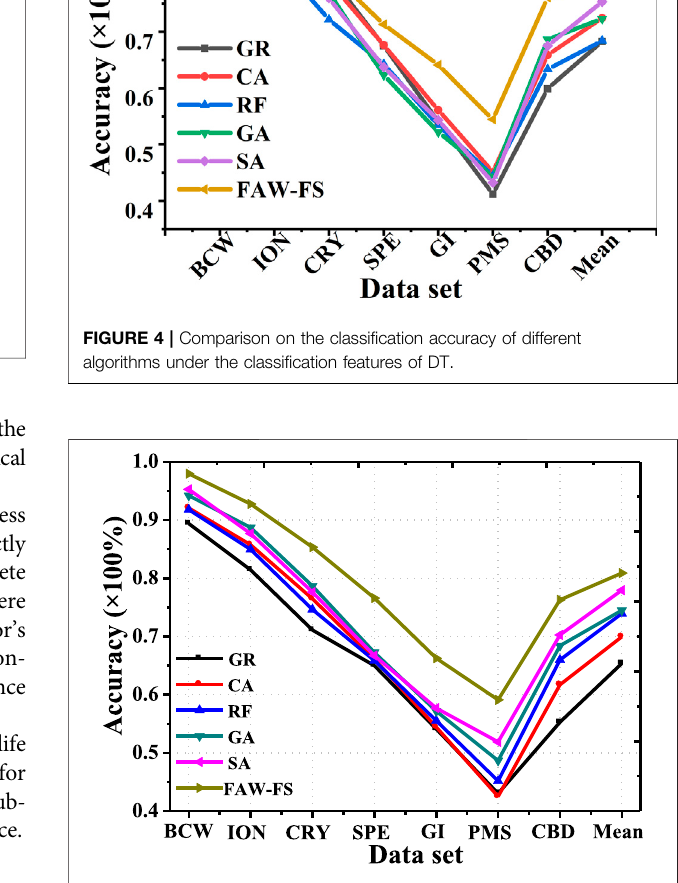
FIGURE 5 | Comparison on the classi fi cation accuracy of different algorithms under the features of K-nearest neighbor